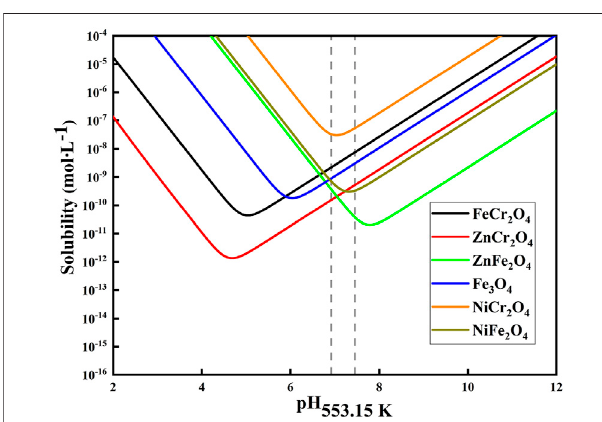
FIGURE 7 | Solubilities of spinel oxides formed on 304SS in the high temperature